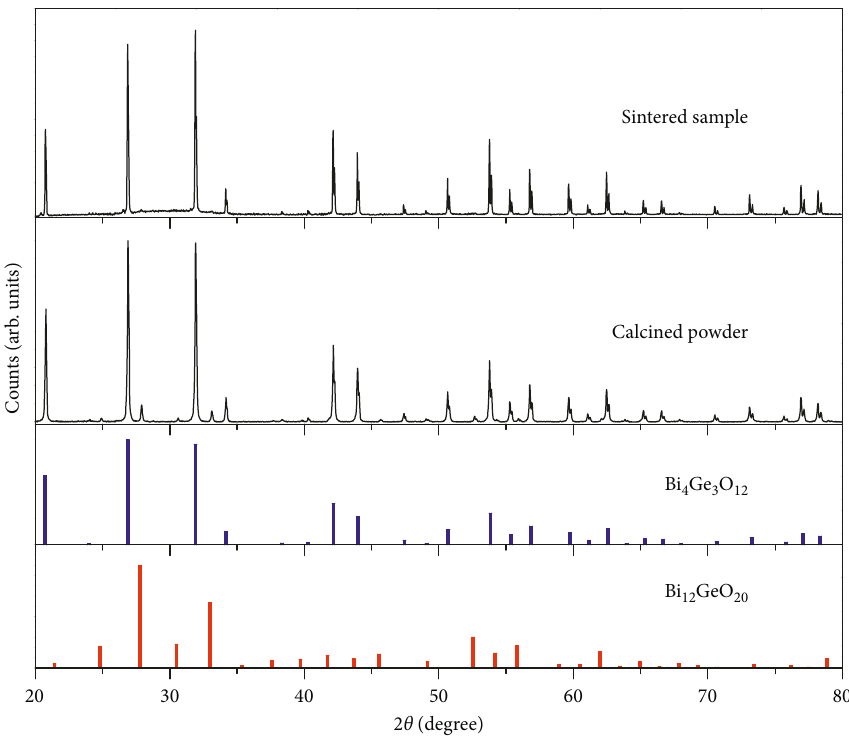
Figure 1: XRD patterns of the BGO calcined powders and sintered ceramics. Before sintering, the samples showed main Bi phases with some XRD peaks due to the Bi 12 GeO 20 crystalline phase. Sintered ceramics show only the Bi 4 Ge 3 O 12 crystalline